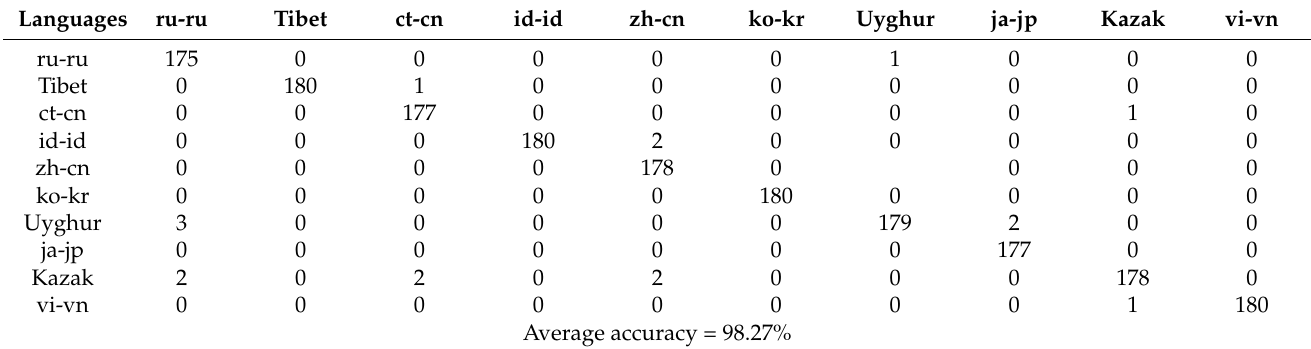
Table 7. Confusion matrix of the OLR dataset for the Oriental language identification.